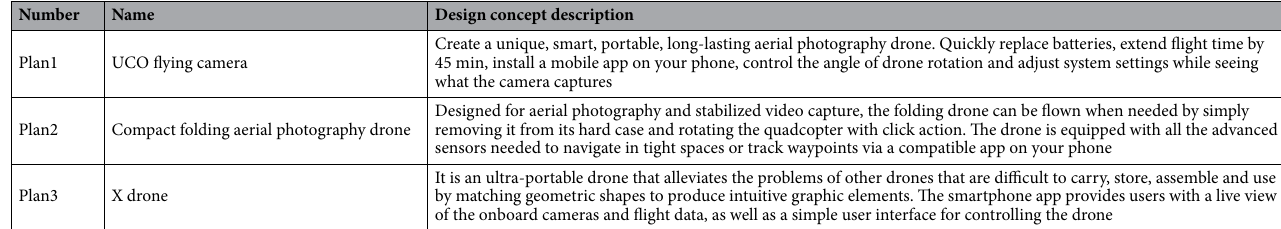
Table 8. Basic information on three aerial drone design concept plans.